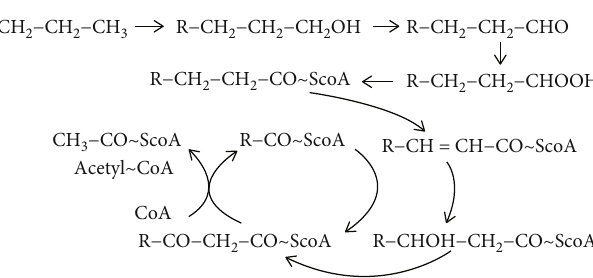
Figure 1: Degradation of n -alkanes to acetyl-CoA by β -